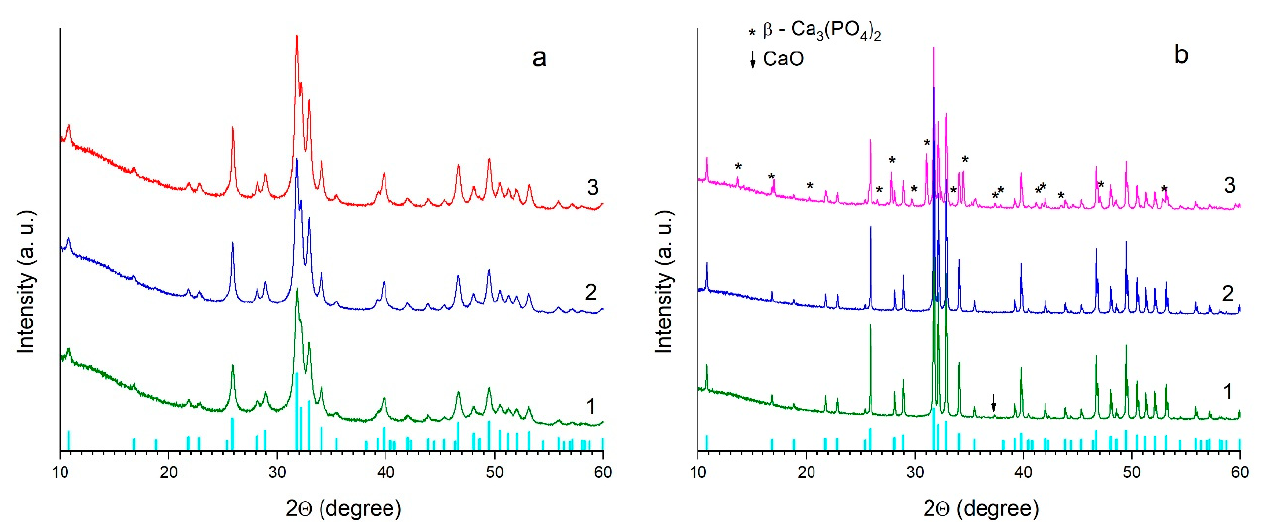
Figure 1. PXRD patterns of the as-synthesized HA powder ( a ) and samples obtained after 2 h of annealing at 1000 °C ( b ). Ca/P ratios are 1.7 (1), 1.667 (2), and 1.6 (3). Vertical bars in the lower graphs correspond to the HA phase from the ICDD database (PDF No. 40-11-9308).